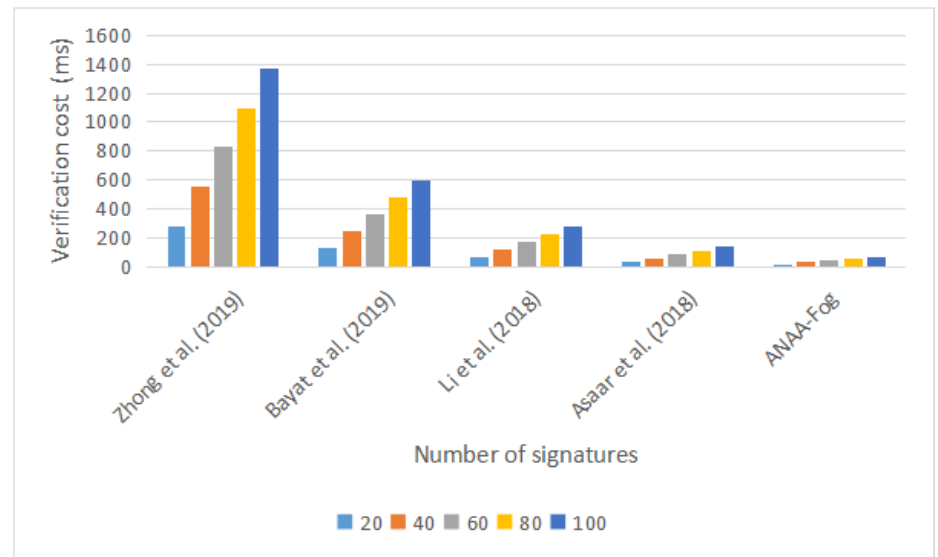
Figure 7. The time cost of verifying a large number of signatures in a batch.